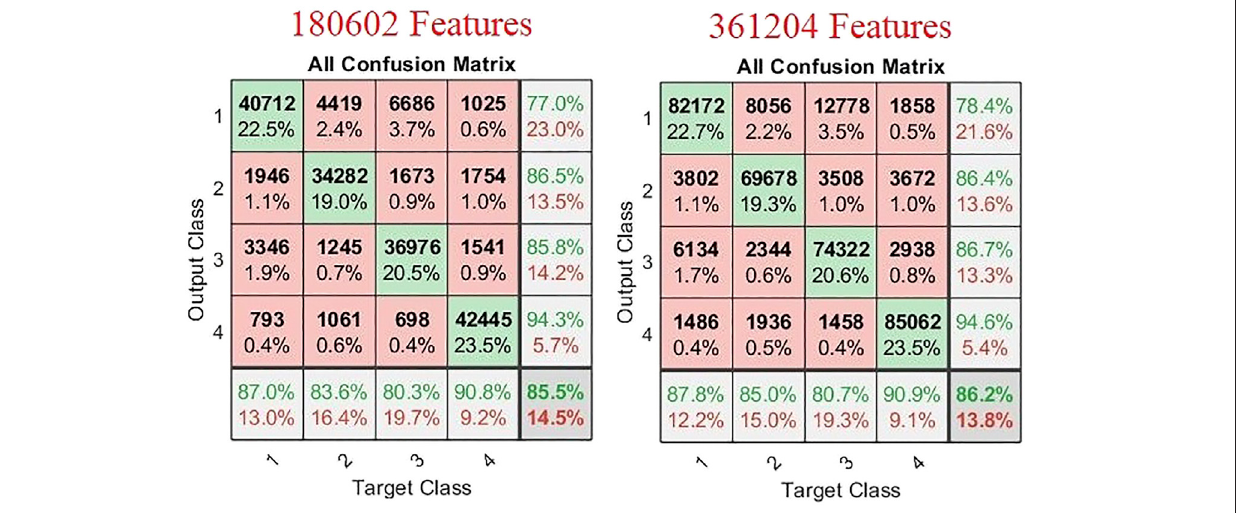
Frontiers in Physics |